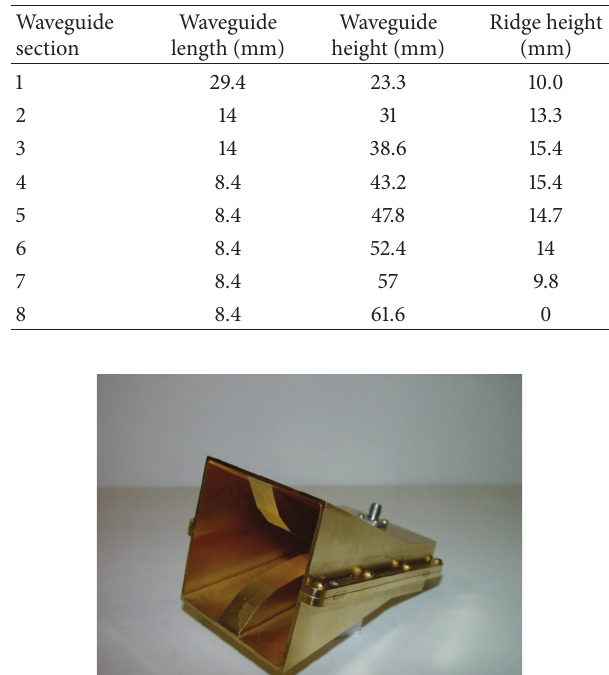
Table 1: Details of the waveguide section: waveguide (WG) size and ridge height.